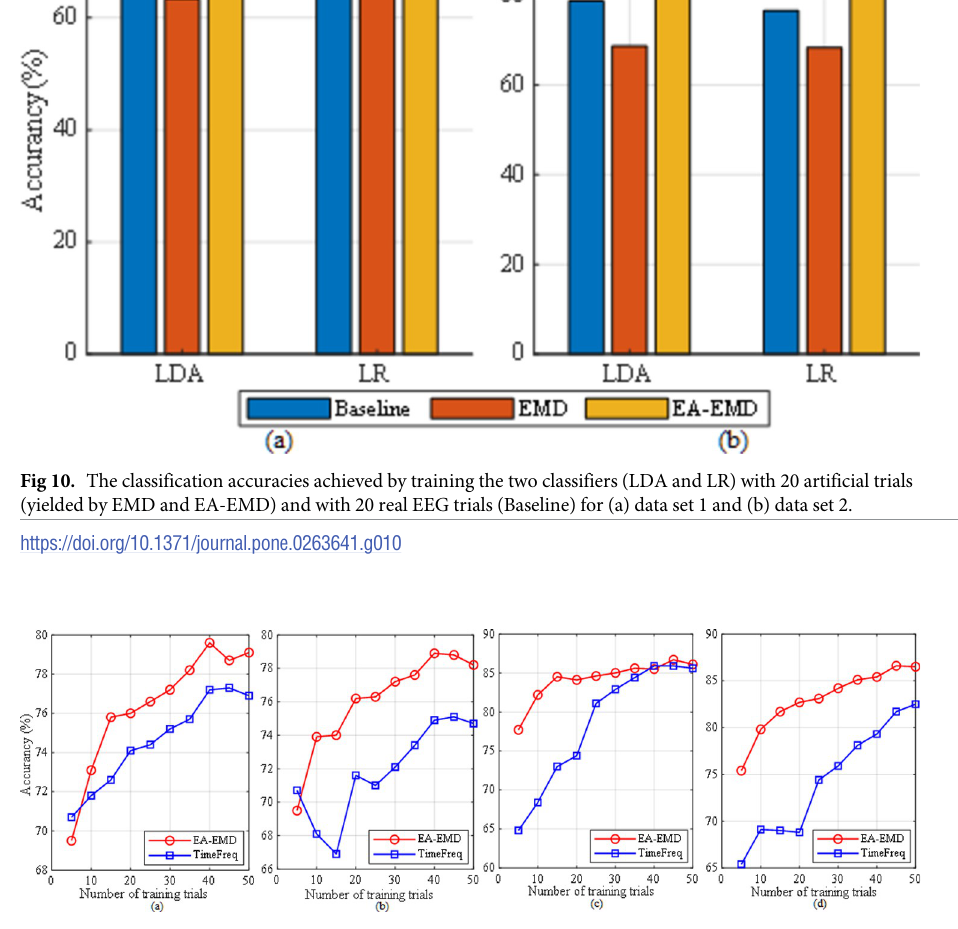
Fig 11. Averaged classification accuracies across all subjects from each data set of two artificial data generation techniques, our p method (EA-EMD) and Lotte’s method (TimeFreq): (a) data set 1 and classifier LDA, (b) data set 1 and classifier LR, (c) data set 2 and classifier LDA, and (d) data set 2 and classifier LR.